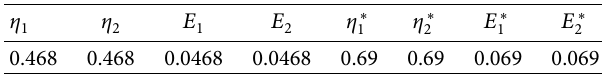
Figure 9: Displacement x decomposition. Table 3: Viscoelastic parameters (the Kelvin